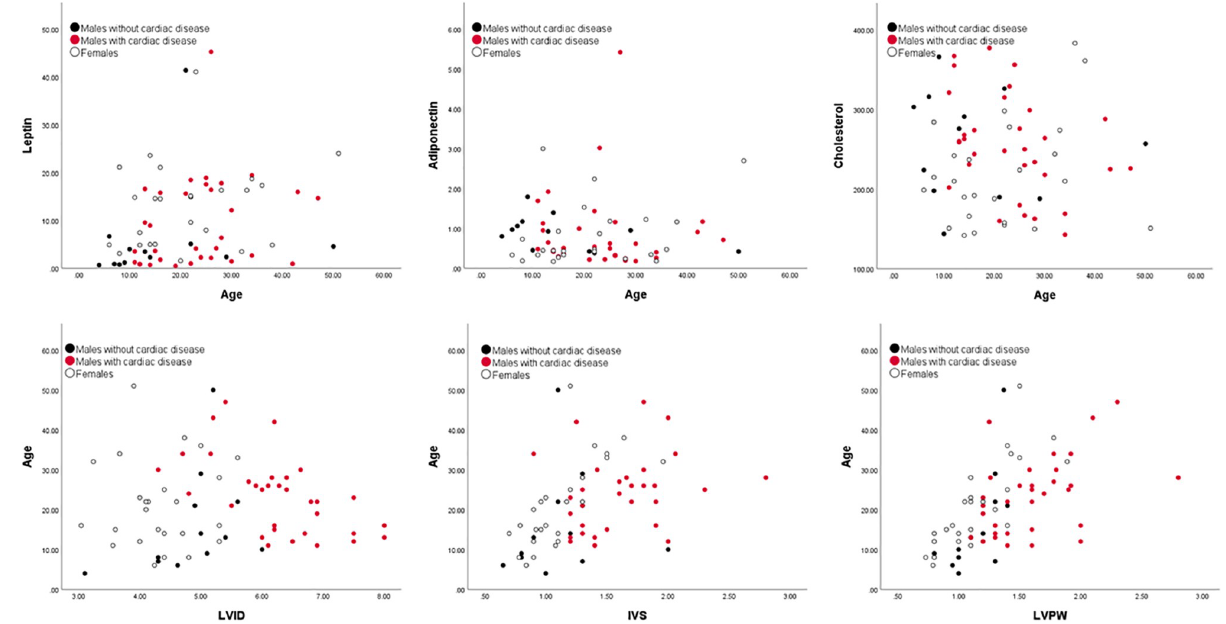
Fig 2. The significant variables for principal component 1 plotted against age and age plotted against heart measures. Leptin, adiponectin and cholesterol are each plotted against age. For males, principal component 1 was significantly correlated with age. Age is also plotted against each heart measure. Males that were previously diagnosed with heart disease are indicated by red circles, healthy males are depicted by black circles and females by white circles.